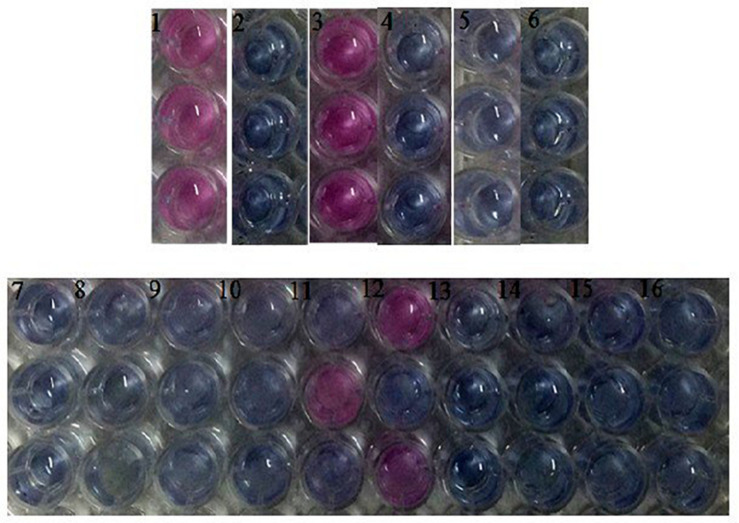
Microplate after 136 H of inoculation with test groups placed on triplicate. (1) Growth control (L.amazonensis); (2) 10 mM AmpB; (3) Growth control (L. braziliensis); (4) Negative control (RPMI); (5) Sterile control1; (6) Sterile control2; (7) Positive control [10 mM AmpB]1; (8) PLA/PEG nanofiber with 1% AmpB1; (9) PLA/PEG nanofiber with 0.5% AmpB1; (10) PLA/PEG nanofiber with 0.25% Amp B1; (11) PLA/PEG nanofiber1; (12) PLA/PEG nanofiber2; (13) Positive control [10 Mm AmpB]2; (14) PLA/PEG nanofiber with 1% Amp B2; (15) PLA/PEG nanofiber with 0.5% AmpB2; (16) PLA/PEG nanofiber with 0.25% AmpB2.1Against to L.amazonensis, 2Against to L. braziliensis.